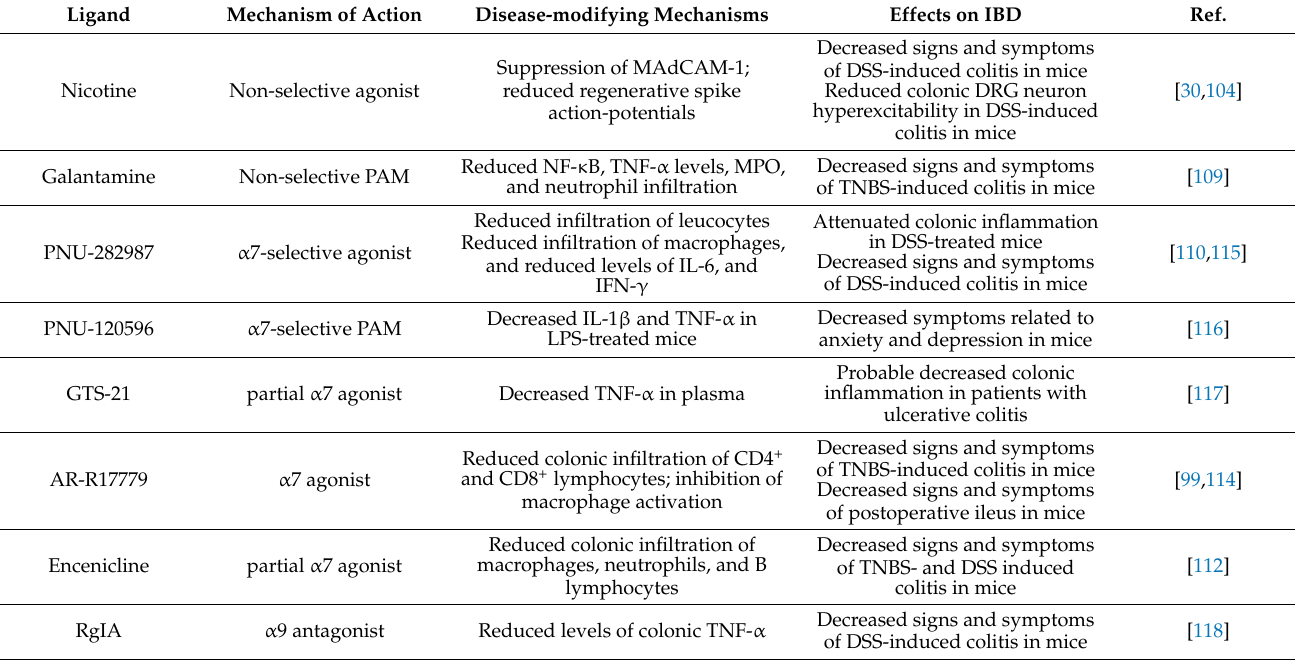
Table 2. Effects of nAChR ligands on murine models and human patients with